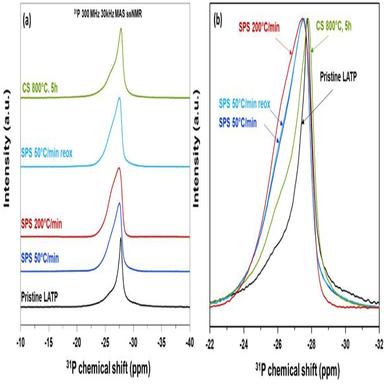
31P NMR spectra of the pristine powder LATP, sintered samples by SPS and conventional method, and re-oxidized sample (a) and the superposition of these spectra to highlight the local environment evolution (b). Fig. S5 gives as an example in supplementary information the deconvolution of the spectrum recorded for the sintered sample CS 800◦C 5 h.